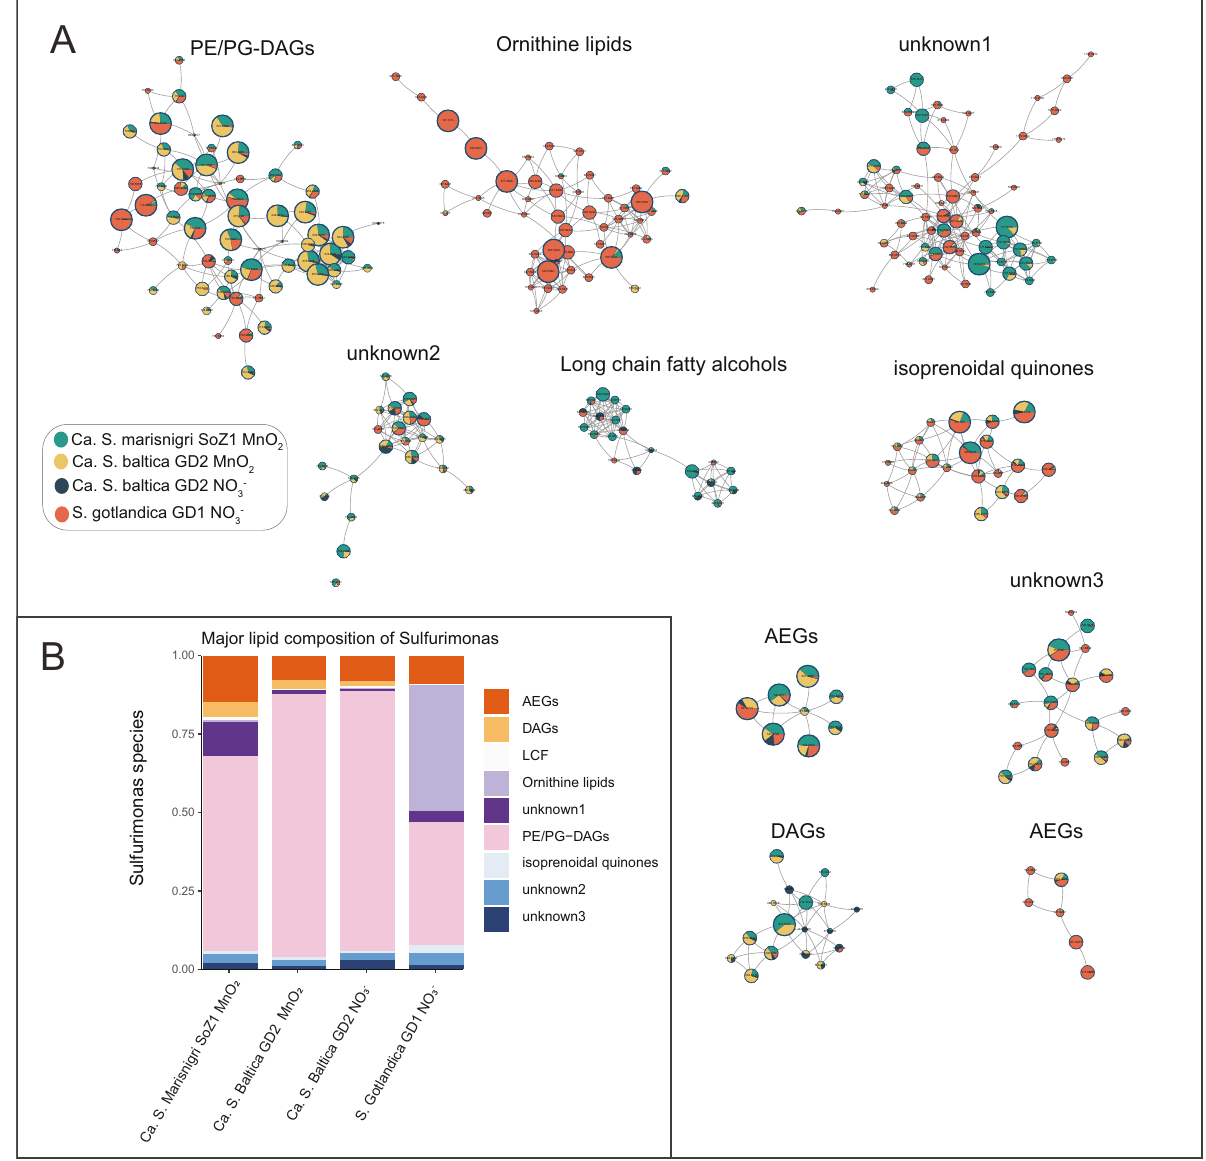
Fig. 1 A Molecular network of the major lipid classes in the Sulfurimonas species ( Ca. S . marisnigri SoZ1, Ca. S . baltica GD2 and S. gotlandica or MnO 2 as electron acceptors. Nodes represent MS/MS spectra of ion components (lipids), which are connected based on GD1 T ) using NO (cid:1) 3 spectral similarity (cosine > 0.6). Nodes are fi lled with pie charts which contain four different colors representing the fractional abundance of the lipid (based on peak intensity) among three Sulfurimonas species with two different treatments. The size of each pie charts represents for the summed intensity of the ion component in all the species using various electron acceptors. The aim of this fi gure is not to compare the abundance of lipids among different Sulfurimonas species, rather than that it provides information on whether speci fi c Sulfurimonas spp. under certain conditions have the ability to synthesize speci fi c lipids. The spatial orientation of the nodes in the MS/MS network is randomly generated by Cytoscape [58, 59] and does not relate to relationships between the subnetworks. Lipid classes (clusters) with annotation are either tentatively identi fi ed in this study or have been annotated from the GNPS library (see the method for details). B Major lipid class composition (based on peak intensity). DAG diacylglycerol, AEG acyletherglycerol, LCF long chain fatty acids, PE phosphatidylethanolamine, PG phosphatidylglycerol. There are also three unknown lipid classes, the structure of unknown lipid 1 will be discussed in Fig. 3. The other two lipid classes are lipids with polar headgroups that we could not identify based on their mass spectra. However, their mass spectra indicate that they comprise a DAG core (Fig.